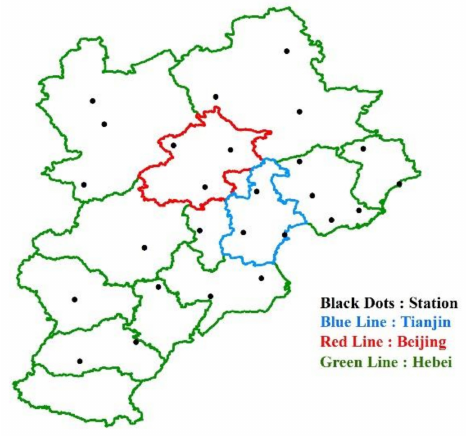
Figure 1. Study area